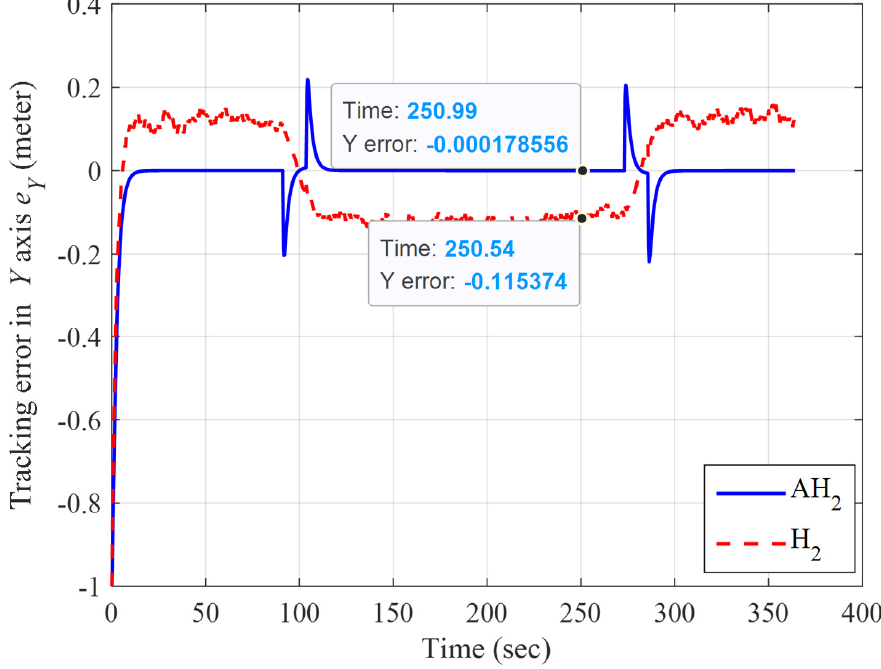
Figure 15. The square trajectory tracking error result of the adaptive H 2 closed-form and H 2 closed- form control approaches for Y from x p = 7 m, y p = − 7 m.